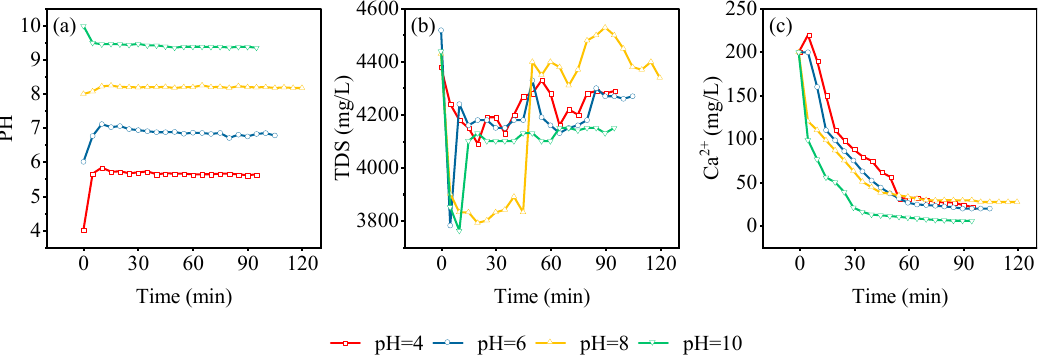
Figure 12. Solution characteristics of medium-grained coarse sandstone subjected to dynamic leaching by mine water at different pH values: ( a ) pH value; ( b ) TDS concentration; ( c ) Ca 2+ concentration.